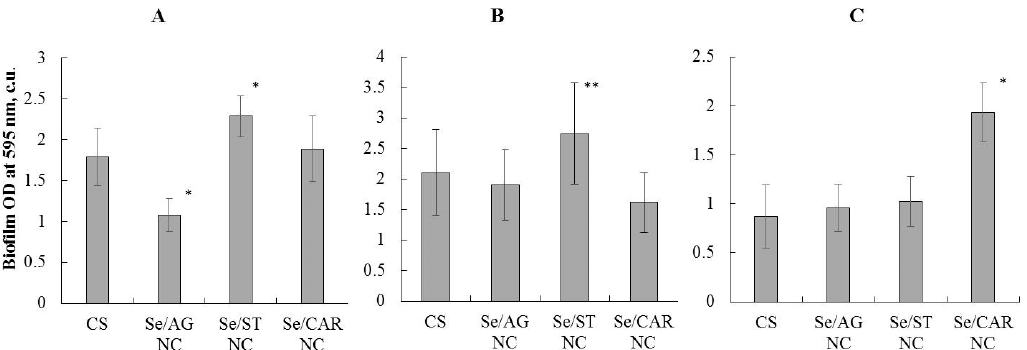
Figure 9. Effect of the Se NC treatments (with 105.57 µ g/mL for Se/AG NC, 428.08 µ g/mL for Se/ST NC, and 170.30 µ g/mL for Se/CAR NC, which corresponds to the Se concentration of 6.25 µ g/mL in the final solution) on the biofilm formation of rhizosphere bacteria A. guillouiae ( A ), R. erythropolis ( B ), and P. oryzihabitans ( C ); * p < 0.01, ** p < 0.05 (in comparison with CS) based on 9 independent observations per each Se NC, control and bacteria.